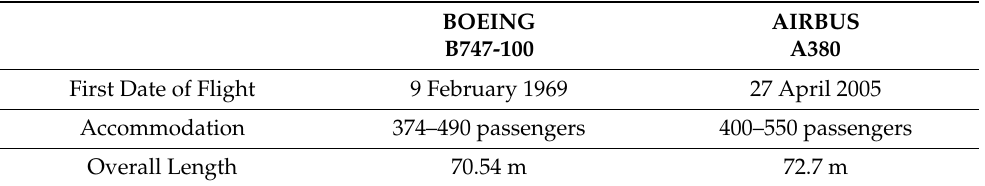
Table 2. Boeing and Airbus aircraft model comparison; B747-100 vs.